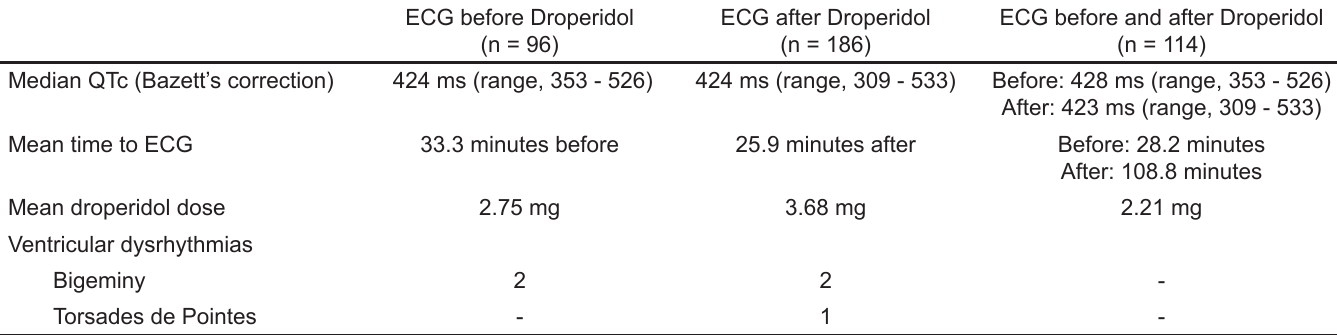
Table. Characteristics and electrocardiogram data for critically ill patients receiving droperidol (n =